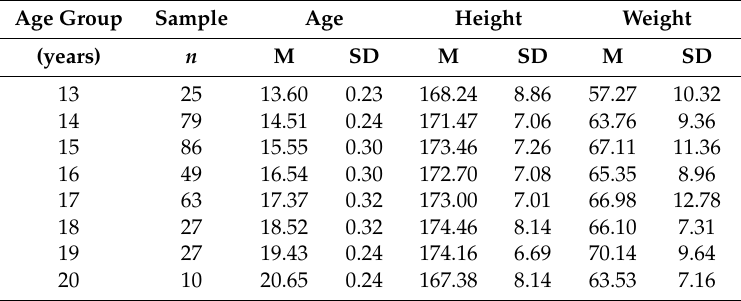
Table 2. Sample sizes and descriptive statistics (means (M) and standard deviations (SD)) for age, height, and weight of female athletes by age